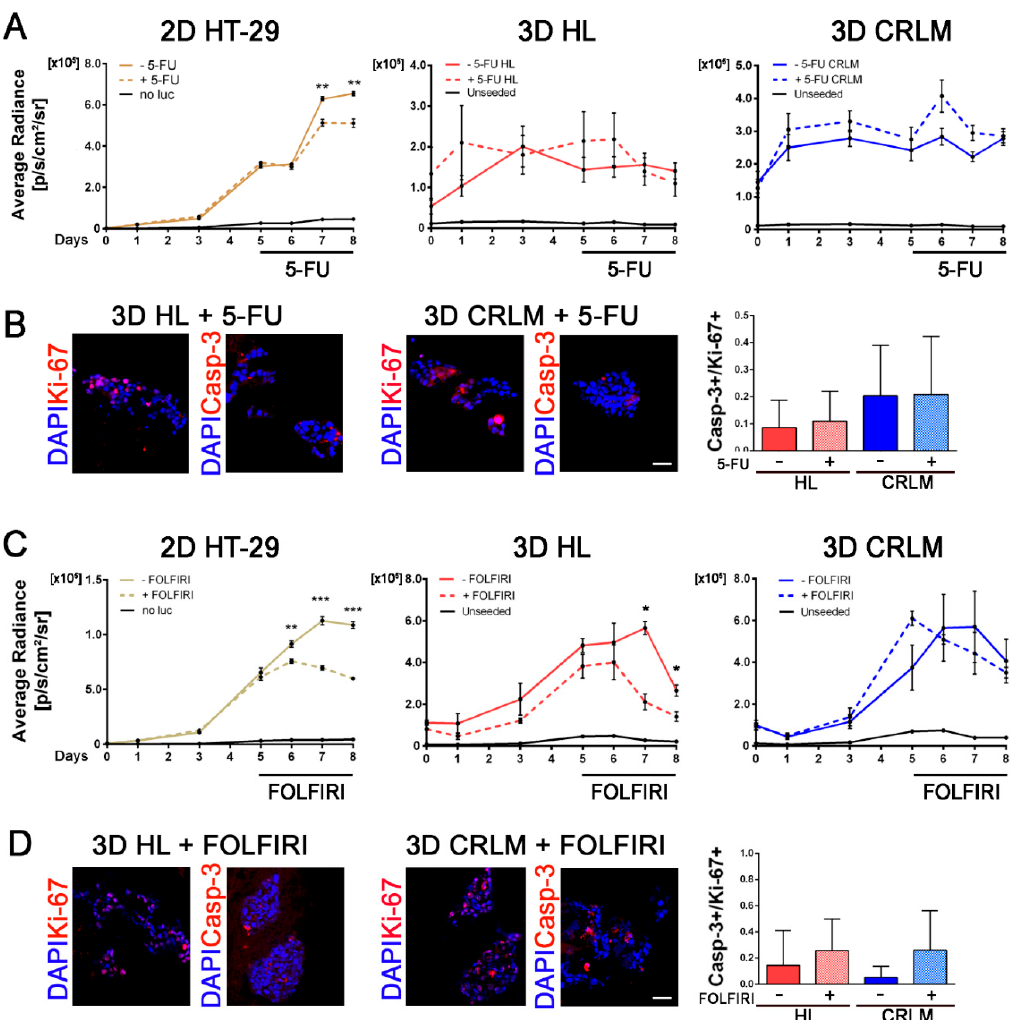
Figure 6. Chemotherapy treatment of recellularized HL and CRLM scaffolds and HT-29 cultured in 2D. ( A ) Cell viability measured in response to treatment with 5-FU. HT-29 cells were cultured in 2D (brown, +5-FU dotted line/-5-FU continuous line; n = 3 replicates) or in HL ( n = 6) and CRLM ( n = 6) scaffolds (respectively, red and blue, +5-FU dotted line/-5-FU continuous line) for 5 days and then exposed to 5-FU (1µM) for 3 days. Cultures without the addition of 5-FU or D-Luciferin (black), or unseeded scaffolds (black), were used as controls. ( B ) Representative i mmunofluorescent images and quantifications at day 8 of HT-29-recellularized scaffolds treated with 5-FU. Ki-67 + (Red) and activated Caspase-3 + (Red) cells; nuclei were counterstained with DAPI (blue). (C) Cell viability measured in response to treatment with FOLFIRI. HT-29 cells were cultured in 2D (brown, +FOLFIRI dotted line/- FOLFIRI continuous line; n = 3 replicates) or in HL ( n = 9) and CRLM ( n = 9) scaffolds (respectively, red and blue, +FOLFIRI continuous line/-FOLFIRI dotted line) for 5 days and then exposed to FOLFIRI (1 µM) for 3 d. Cultures without the addition of FOLFIRI or D-Luciferin (black), or unseeded scaffolds (black), were used as controls. ( D ) Representative i mmunofluorescent images and quantifications at day 8 of HT-29-recellularized scaffolds treated with FOLFIRI. Ki-67 + (Red) and activated Caspase-3 + (Red) cells; nuclei were counterstained with DAPI (blue). Scale bar: 50 µm. For line graphs, * p -value < 0.05; ** p -value < 0.01; and *** p -value < 0.001 by Student’s t -test.